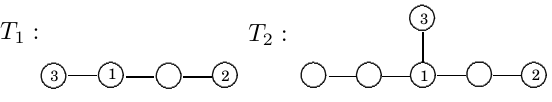
Figure 5: Minimal trees in a tree T with ˜ γ ( T ) = 3